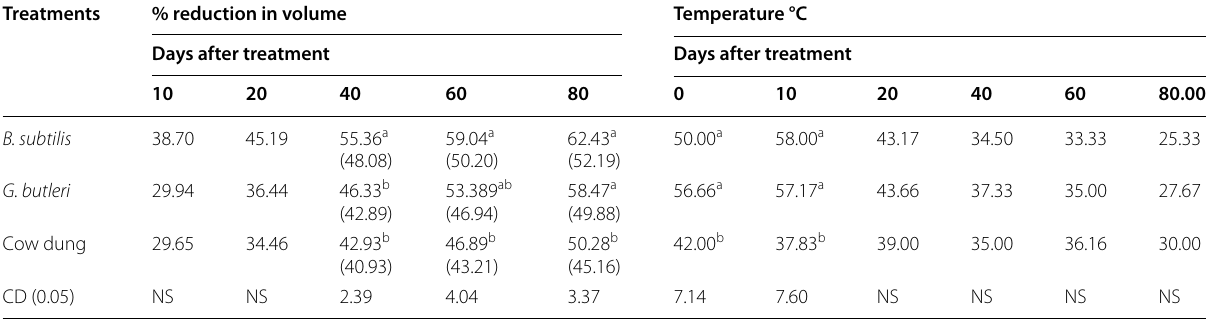
Table 2 Reduction in volume and heat generation under composting using G. butleri , B. subtilis , and cow dung